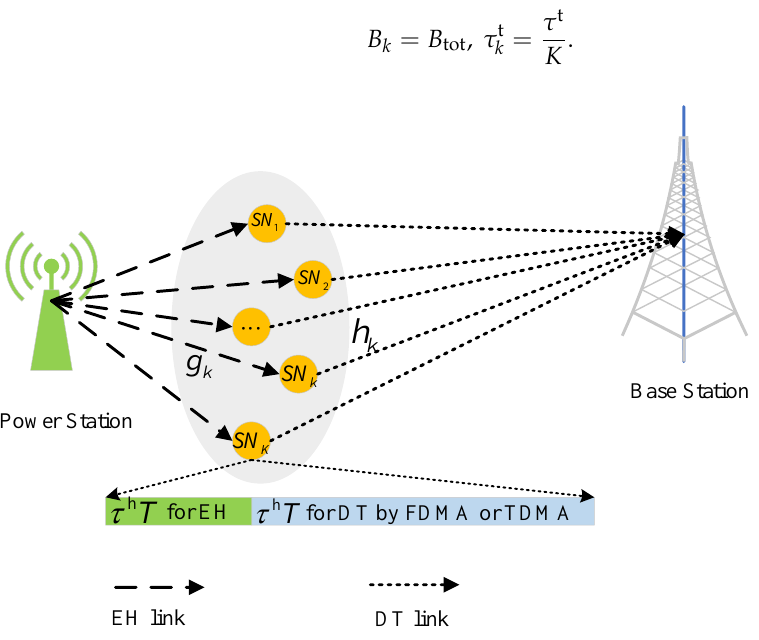
Figure 2. Communication model of the sensor